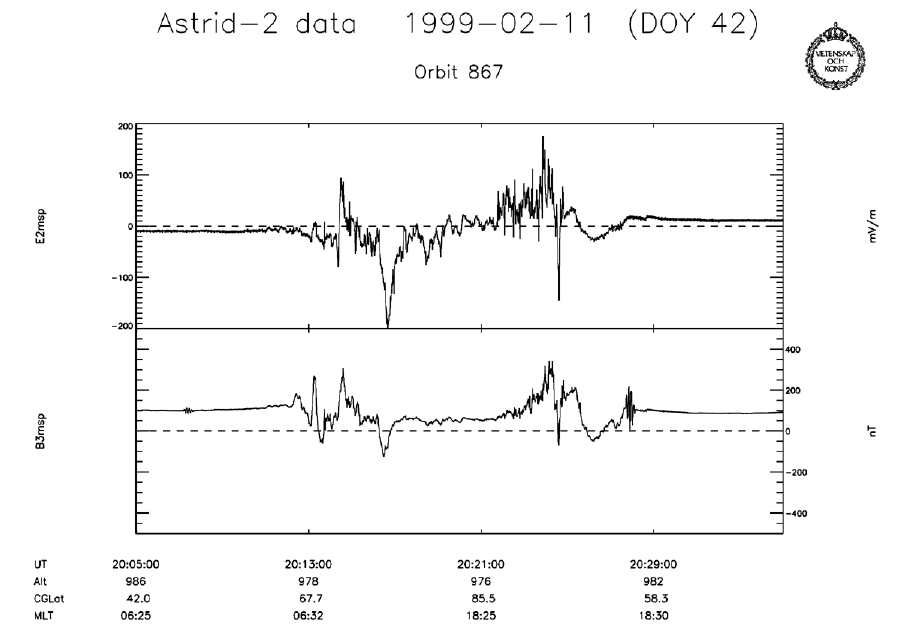
Fig. 6. Electric and magnetic field data from a polar pass through a transpolar auroral